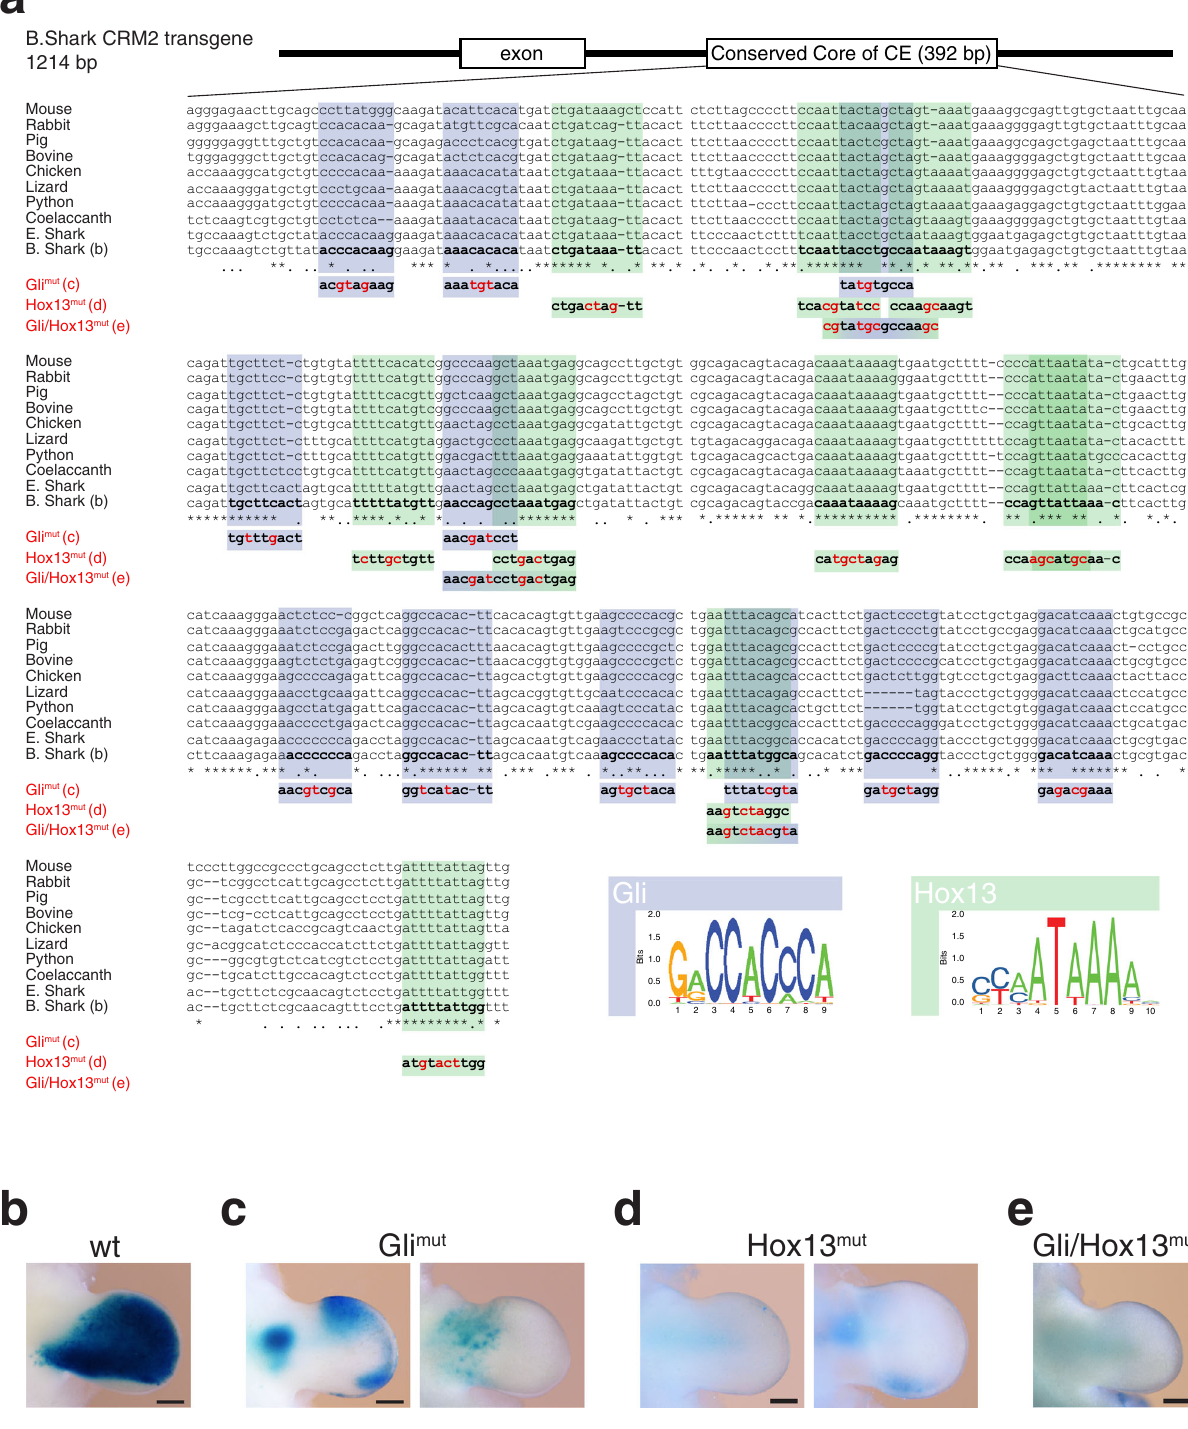
Mouse Rabbit Pig Bovine Chicken Lizard Python Coelaccanth E. Shark B. Shark (b)